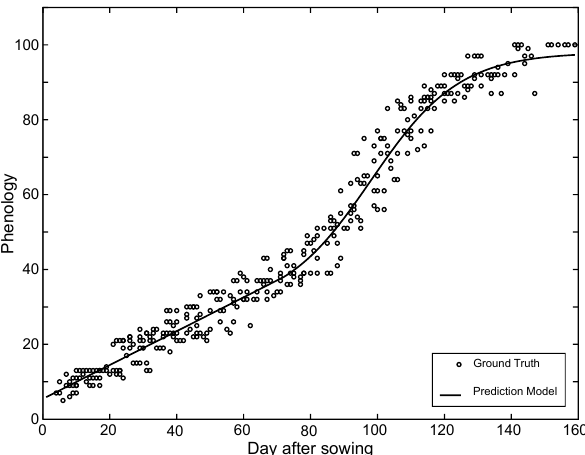
Figure 2. Measurements of phenology (ground truth) for different parcels at different years, plotted against the day after sowing (black circles). The solid line corresponds to the model defined in Equation (13). m = 0.4458, n = 5, r = 0.0661, t 0 = 97.6413, t c = 62, a = 26.2956 and b =